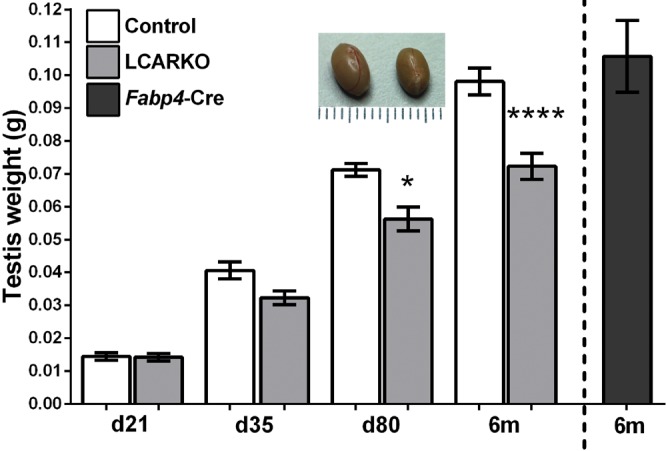
LCARKO mice have reduced testis size and weight. The mean weight of LCARKO testes is comparable with controls at d 21 (14.49 mg control; 14.21 mg LCARKO) and d 35 (40.62 mg control; 32.32 mg LCARKO). At d 80, the LCARKO mean testis weight is significantly reduced compared to controls (71.19 mg control; 56.28 mg LCARKO; *P < 0.05), and testes are visibly smaller (photo inset; scale bar increments of 1 mm). At 6 mo (6m) old, the mean LCARKO testes weight is also reduced compared to controls (98.08 mg control; 72.29 mg LCARKO; ****P < 0.0001). Error bars, sem.